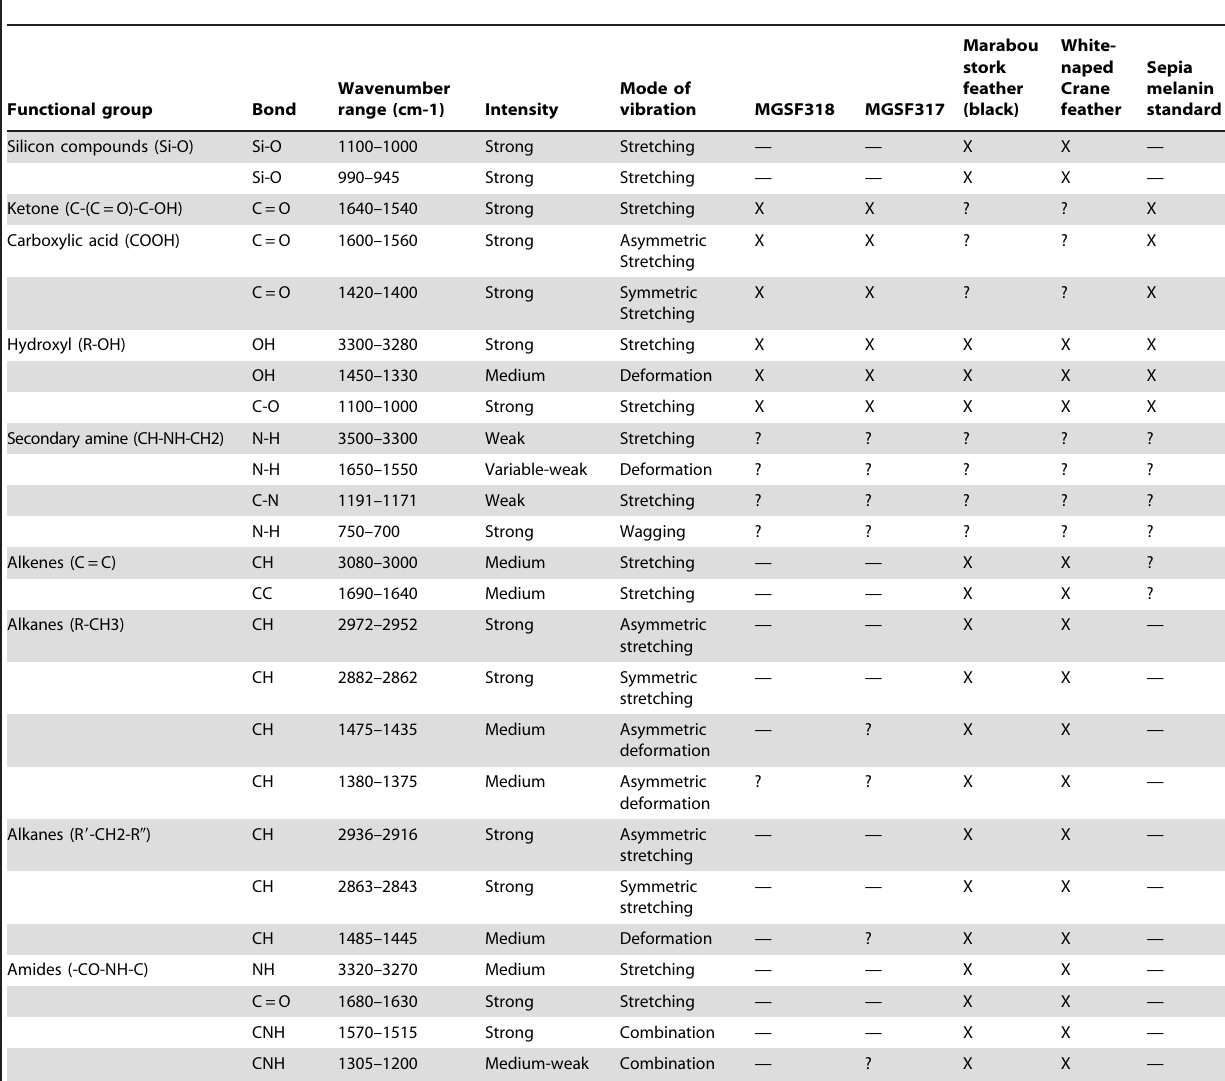
Table 2. Infrared peak assignments for Sepia officinalis melanin, extant Marabou stork and White-naped Crane feathers and fossil Gansus yumenensis feathers MGSF317 and